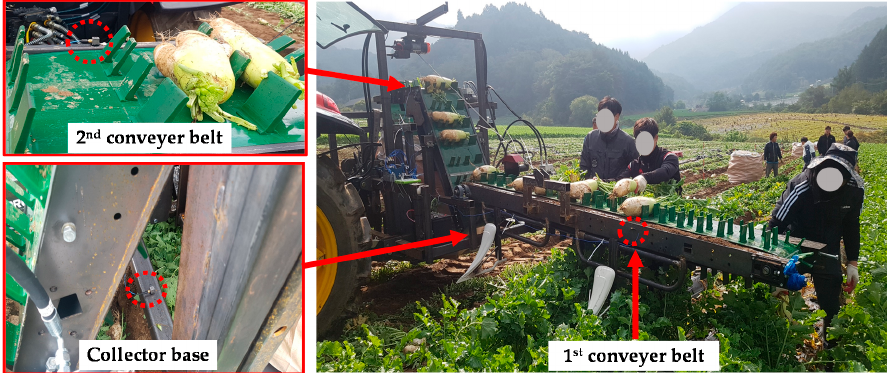
Figure 4. Positions of the vibration sensors in the radish collector during the field